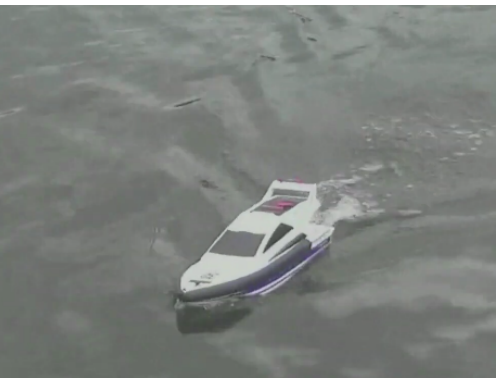
Figure 1. An autonomous DDboat robot used for the experimental